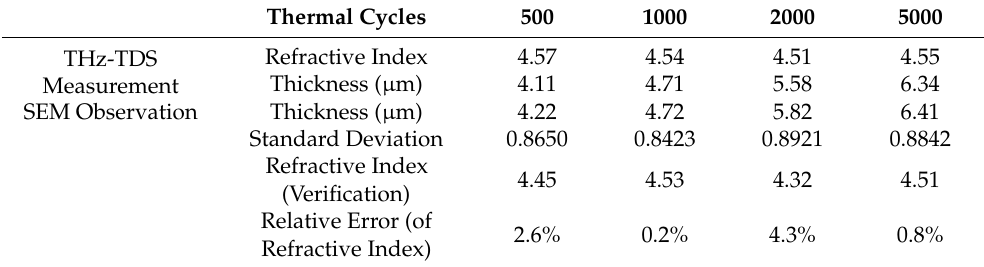
Table 1. The results of the measurement and SEM observation about